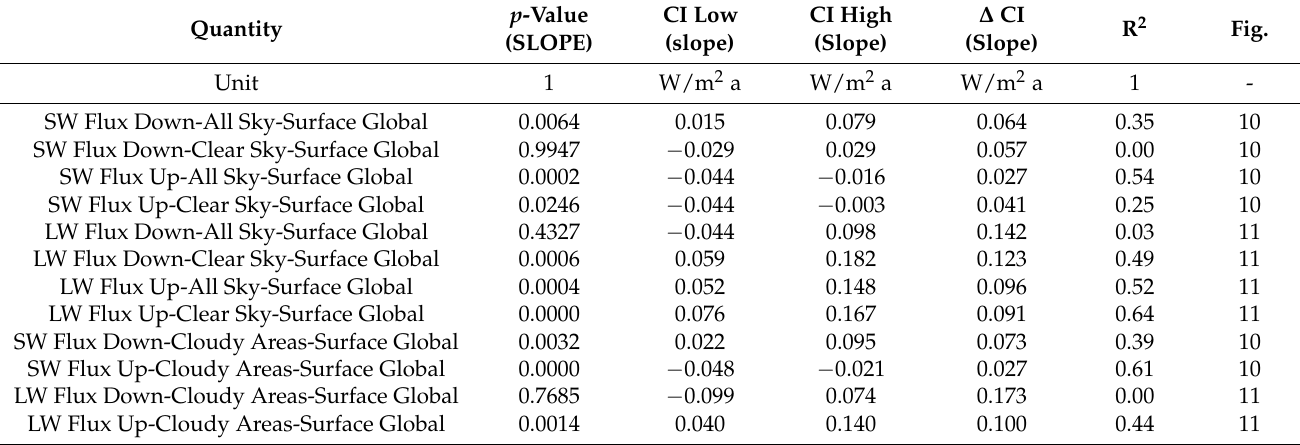
Table A4. Statistical Error Analysis of the Surface Fluxes